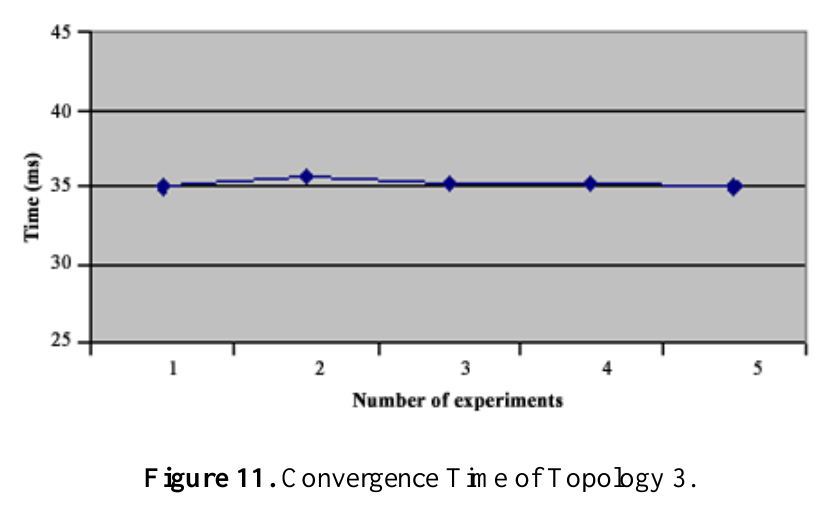
Figure 10. Convergence Time of Topology 2.